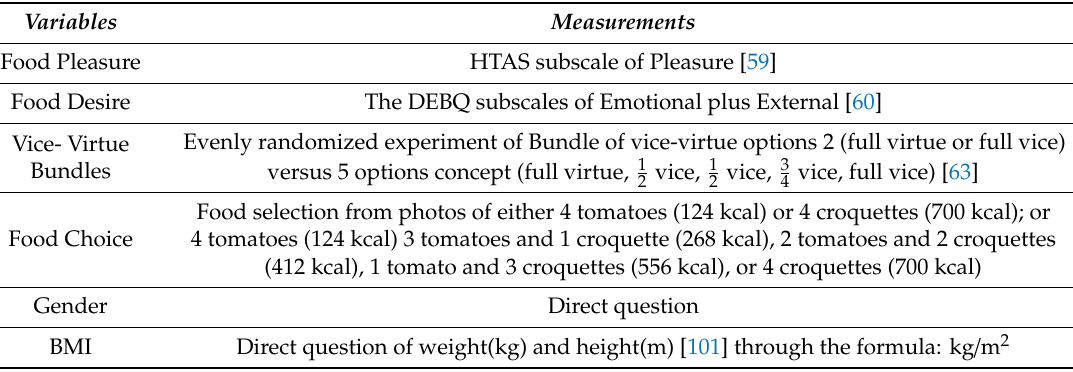
Table 1. Variables and measurements